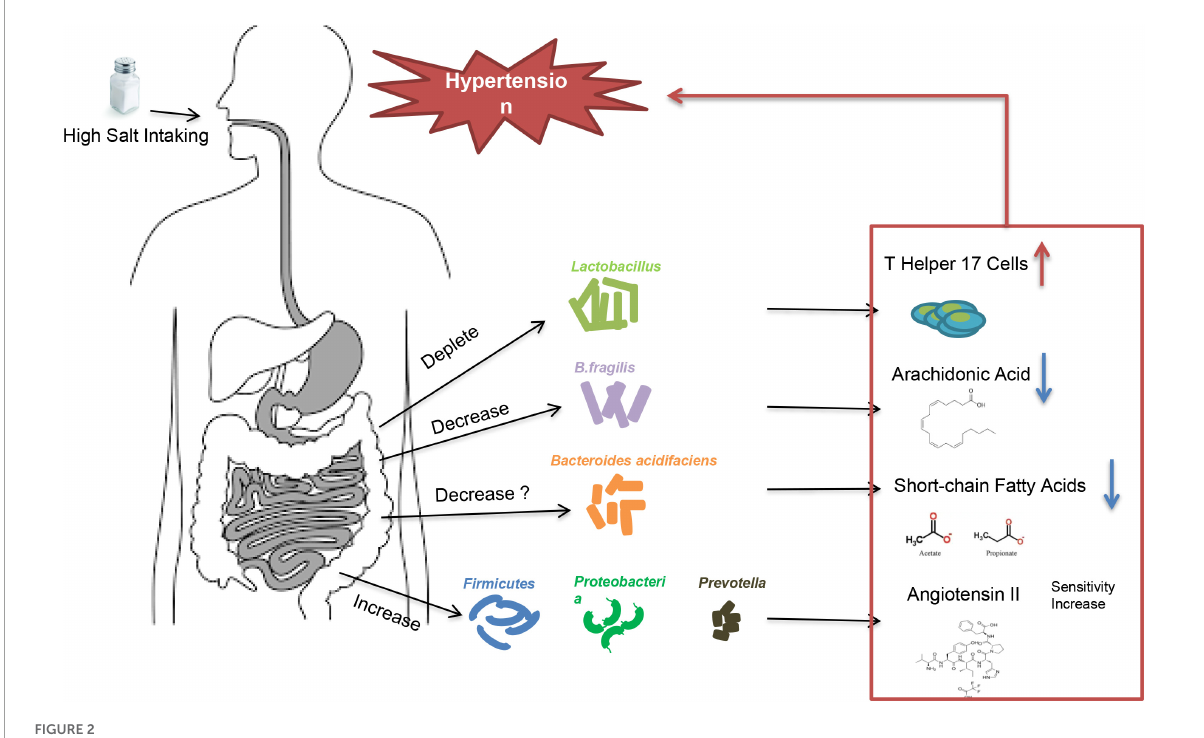
FIGURE2 High salt intake triggers high blood pressure through intestinal